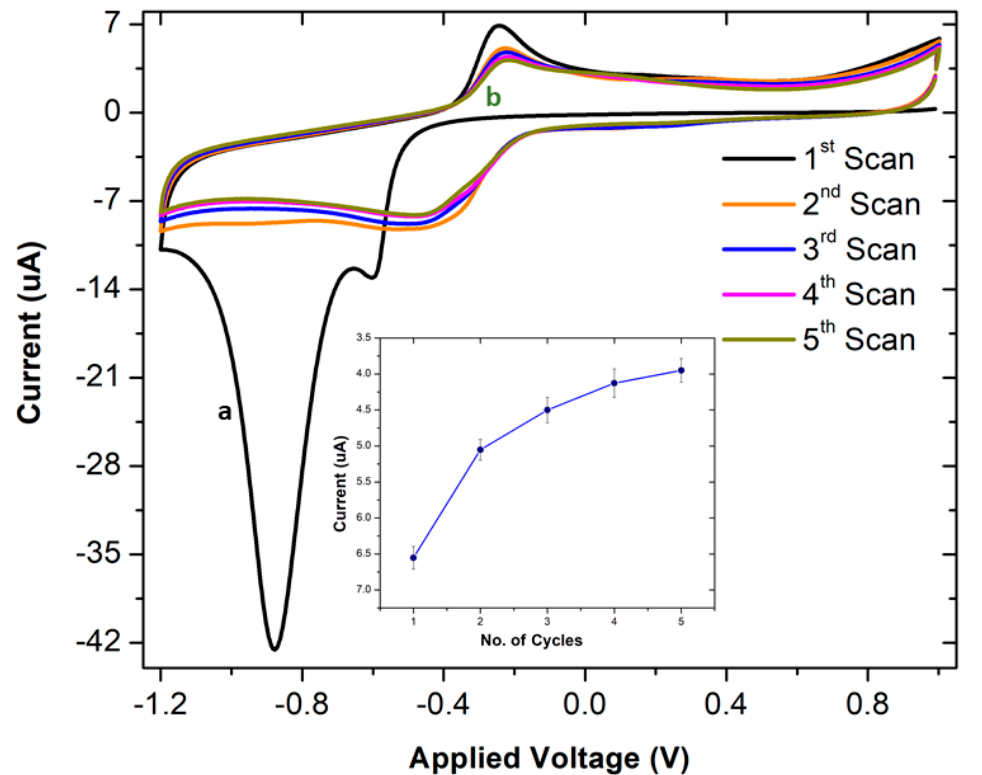
Figure 2. Cyclic voltammograms (50 mV/s) of the reduction of surface-grafted 4-nitrophenyl on GCE in 0.1 M KCl in water:ethanol (9:1) electrolyte: ( a ) black curve—one scan; ( b) green curve—five scans. The inset figure shows the change of peak current with the number of cycles at − 0.2 V . The experiment was repeated four times.